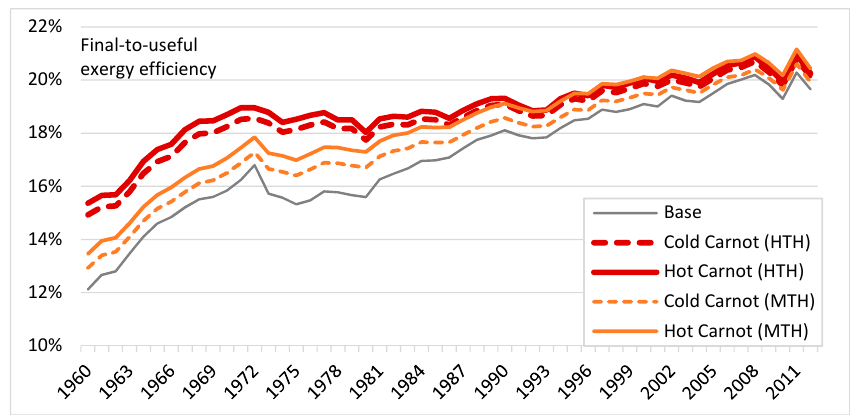
Figure 11. National final-to-useful exergy efficiency under different high- and medium-temperature industrial heat end-use methods.